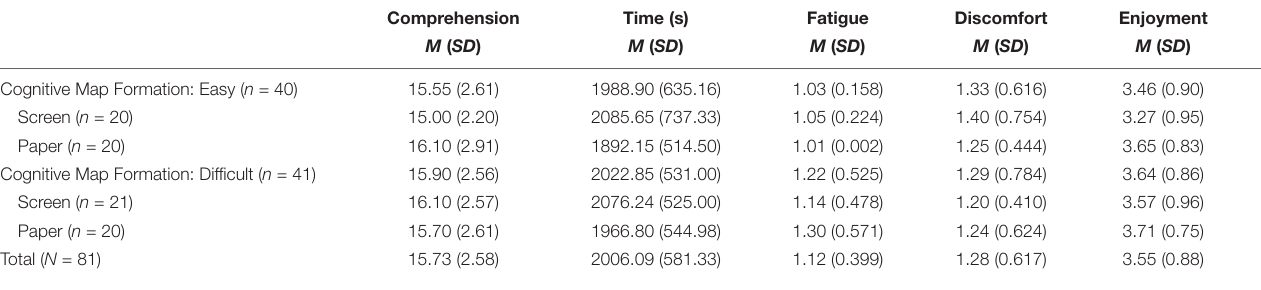
TABLE 1 | Descriptive statistics of study variable by condition.